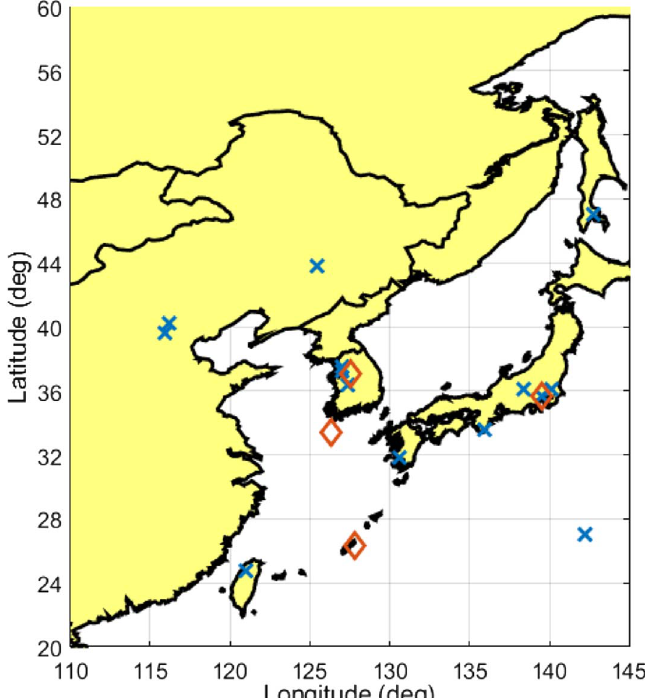
Figure 2. Locations of GPS (blue crosses) and ionosonde (red diamonds) stations used in the